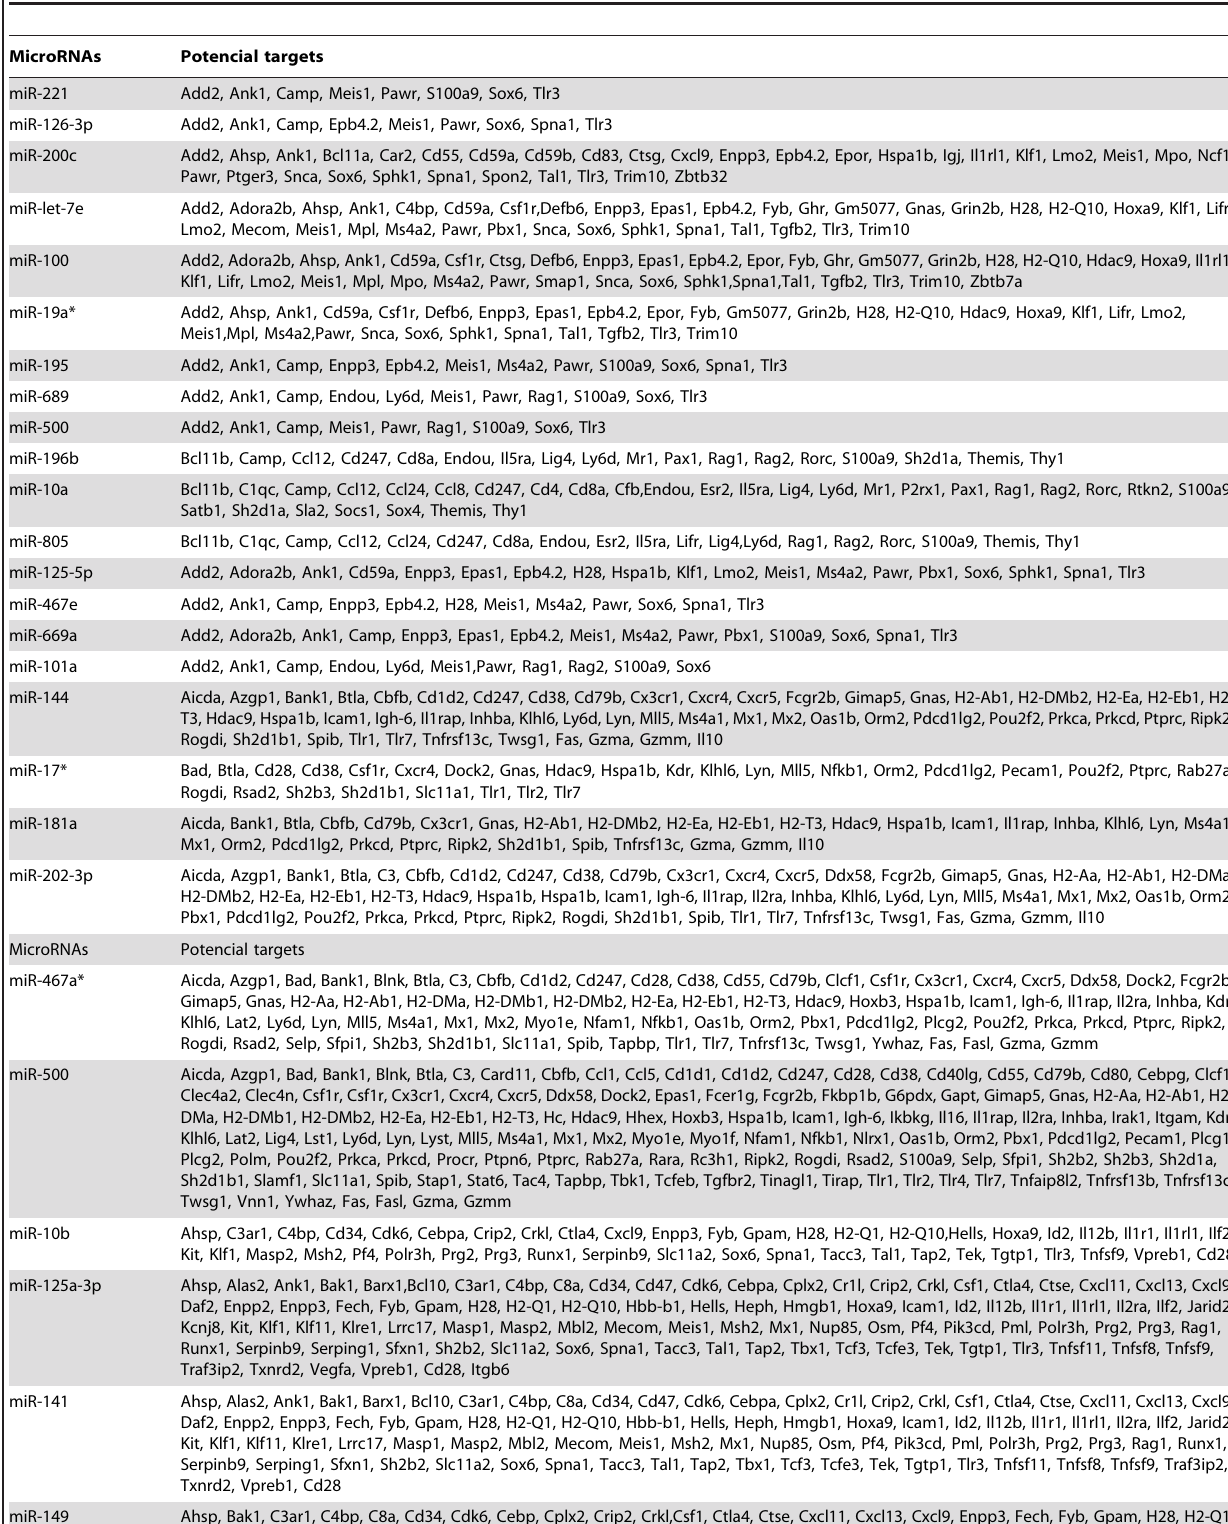
Table 1. Up-regulated microRNAs in thymocytes and CD3 + T lymphocytes in DBA-1/J and DBA-2/J mice strains and their potential targets related to immune system predicted by GenMiR ++